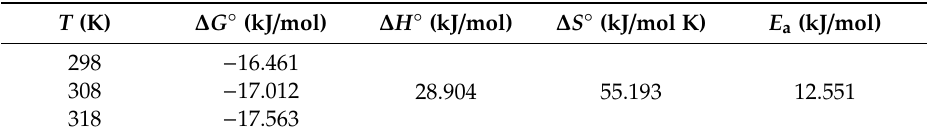
Figure 14. The calculation of adsorption thermodynamic parameters and activation energy by plotting 1/ T ·(1/ K ) versus log K d . Table 5. Thermodynamic parameters and activation energy for adsorption of Pb(II) onto the OPB / PVA / MWCNTs